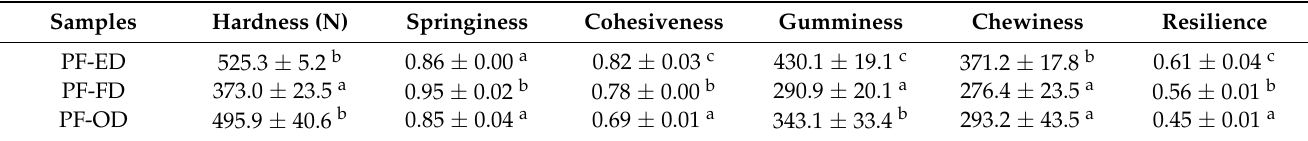
Table 4. Gel textural properties of potato flour by different drying methods.